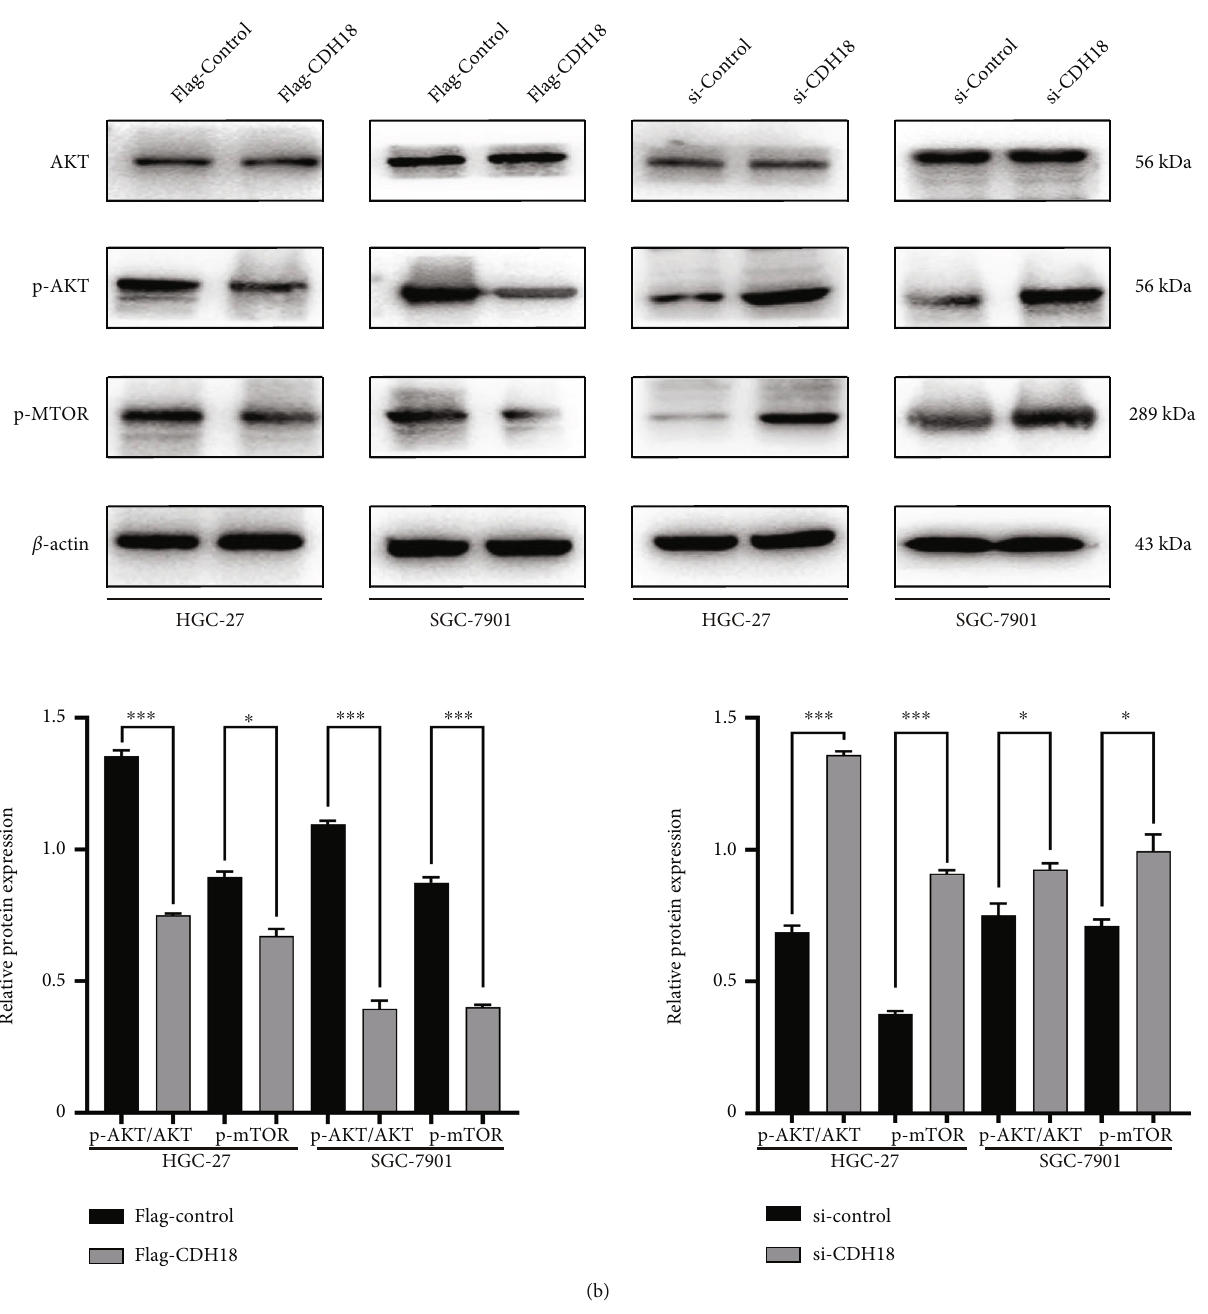
Figure 7: E ff ects of CDH18 on intracellular PI3K/AKT pathway. (a) WB veri fi ed the transfected e ffi ciency of CDH18 in GC cell lines; (b) the e ff ects of CDH18 on the expressions of key molecules in PI3K/AKT pathway. * P < 0 : 05 , ** P < 0 : 01 , *** P < 0 : 001